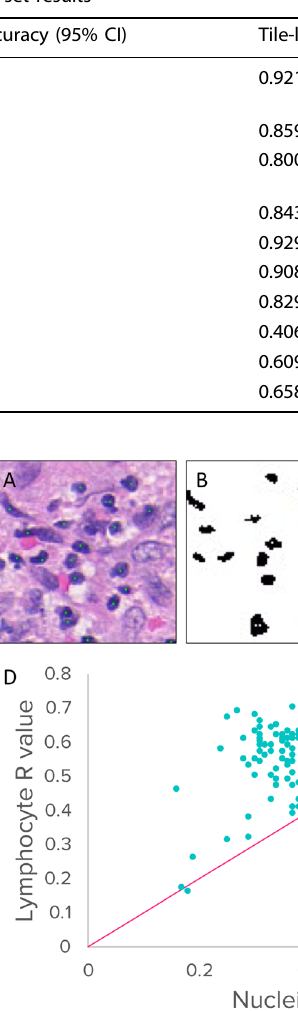
Fig. 1 Associations between lymphocytes and convolutional image fi lters. A H&E stained image with annotated lymphocytes, B lymphocyte mask, C thresholded convolutional activations to 2A, D comparison of fi lter colocalization with lymphocyte and nuclei masks, the line represents